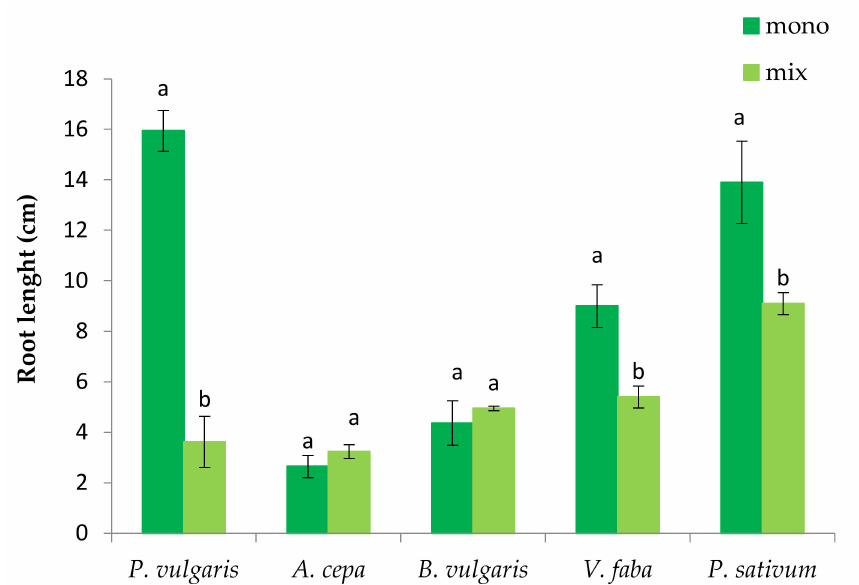
Figure 2. Root length of crop species grown together with P. oleracea seeds (mono = only crop plant; mix = crop grown together with P. oleracea ). Bars represent means of 4 replicates ± SE. Bars topped by the same letter indicate no significant difference between treatments at the 5% level using Duncan’s multiple-range test.